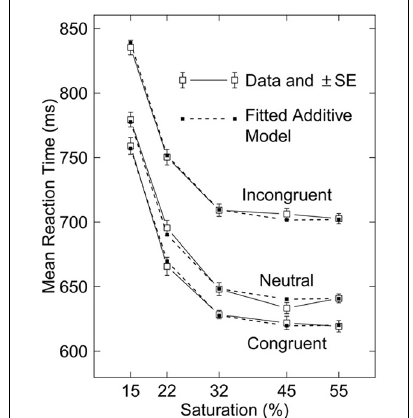
FIGURE 1 | Mean RT data from Stafford et al. (2011, Experiment 1) and fitted additive model. Standard errors (SEs) shown (with mean 5.0ms), which can be used to assess goodness of fit, are based on deviations from additive models plus linear interactions fitted to the 15 mean RTs from each of the 20 subjects. The SE based on the residual mean square (114df) in an anova, after removing the effects of subject, saturation, congruence, their two-way interactions, and the interaction with subjects of the linear interaction of saturation and congruence, is